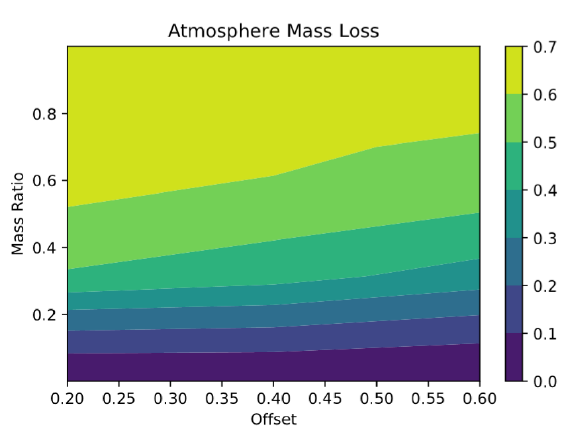
Figure 8. A map of the atmospheric mass loss as a function of the mass ratio between the impactor and target, and the offset between the centres normal to the initial velocity difference, or impact parameter. The velocity is held fixed at 1.5 times the escape